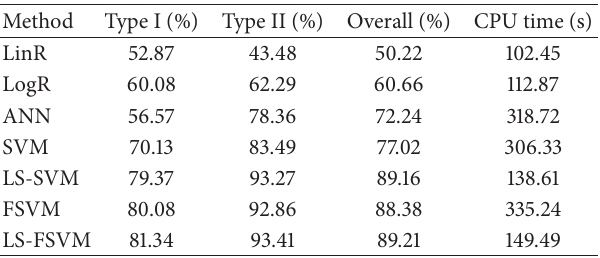
Table 3: Results of comparisons of different classifiers.